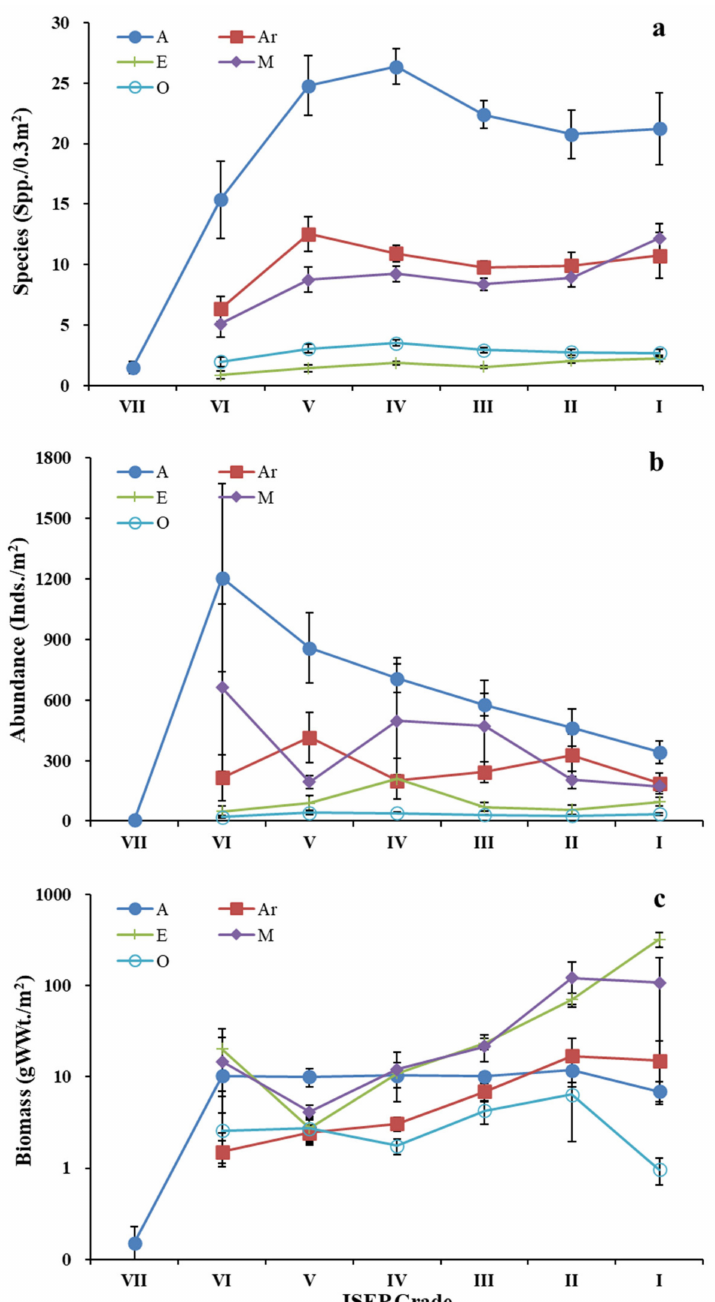
Figure 6. SAB (Species, ( a ); Abundance, ( b ); and Biomass, ( c )) variations of major taxa over ISEP grades. ISEP grades were determined from the data collected along the west coast of Korea. The points are averages, and vertical lines are standard errors. A = annelids, Ar = arthropods, E = echinoderms, M = mollusks, O = others. ISEP grades are shown on the x -axis from low quality (grade VII) to high quality (grade I) to allow comparison with the P-R model. Note that biomass is presented on a logarithmic